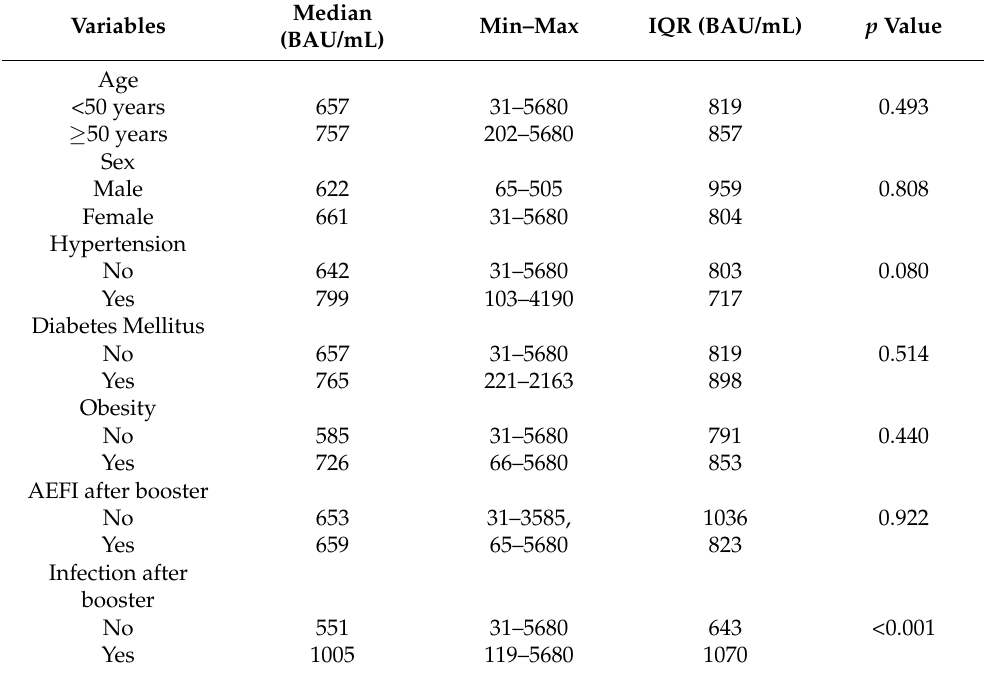
Table 4. Median antibody titer correlation with variables studied (n =